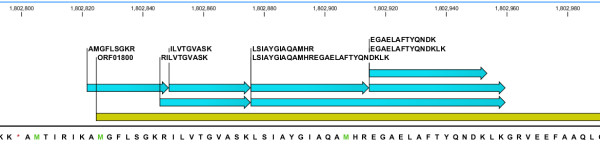
Correcting start site assignment for ORF01800. Multiple peptides (green bars) map to predicted ORF01800 (yellow bar) including one peptide that spans the currently predicted gene start, providing evidence in support of extending the start site. The in-frame * symbol represents the stop codon TAA.